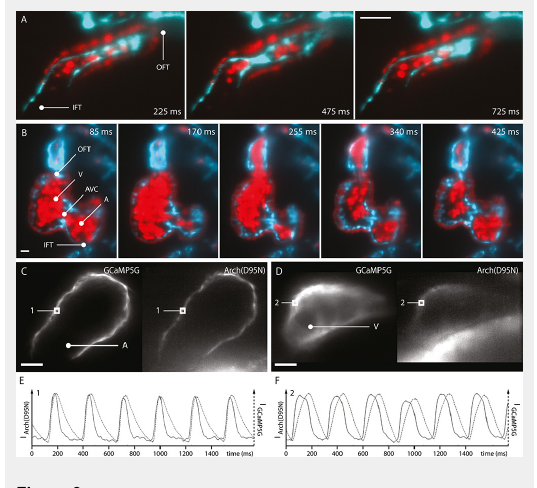
Optical sections of embryonic zebrafish hearts recorded with light sheet microscopy. A: 1 dpf transgenic Tg(kdrl:eGFP,myl7:dsRed, gata1a:dsRed) zebrafish. B: 4 dpf. C: Voltage and calcium imaging in the atrial myocardium of 2 dpf transgenic Tg(myl7:GCaMP5G- Arch(D95N) zebrafish, tnnt2a morpholino-injected. D: Ventricular myocardium. E: Action potentials and calcium transients in the atrial myocardium (position 1). F: Ventricular myocardium (position 2). Inflow tract (IFT), atrium (A), atrioventricular canal (AVC), ventricle (V), outflow tract (OFT). Scale bar: 20 µm.